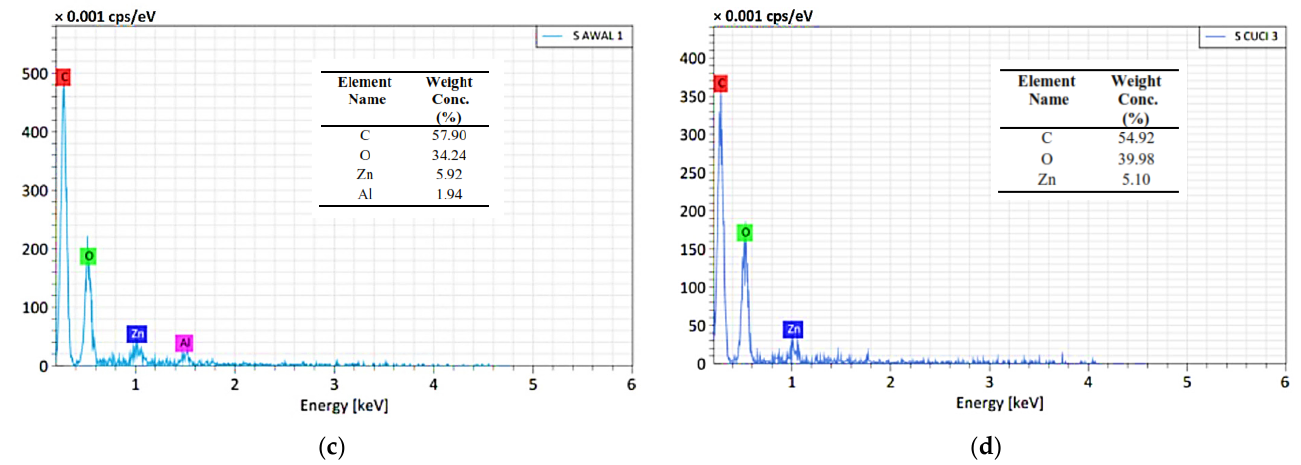
Figure 10. ( a , b ) Morphology (FESEM image) of the ND-colored Batik fabric surface before and after washing, respectively. ( c , d ) Chemical composition of ND-colored Batik fabric from the EDX analysis before and after washing, respectively.